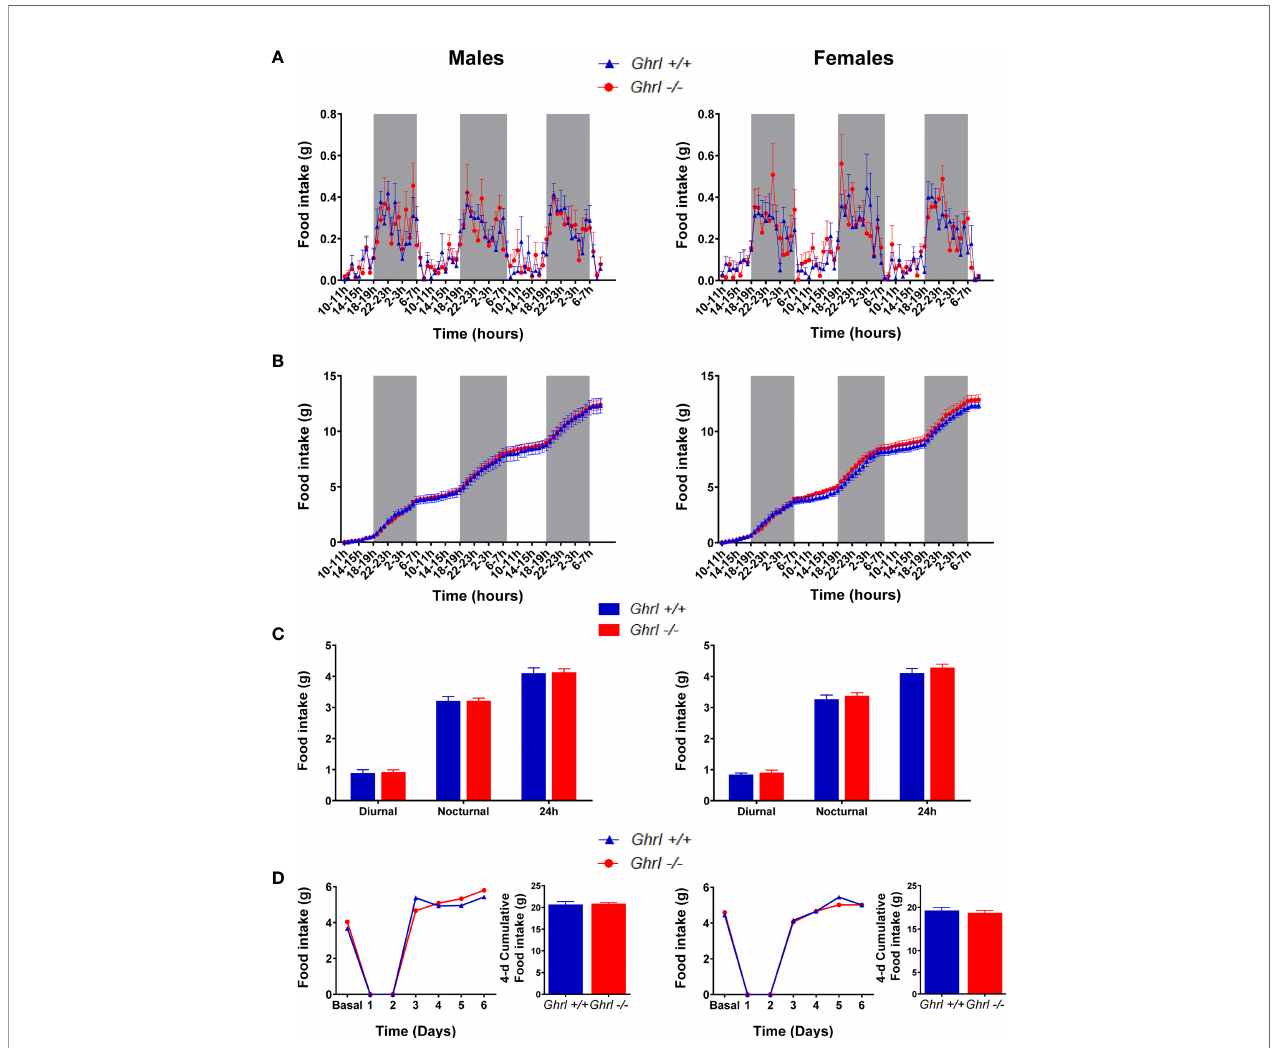
FIGURE 1 | Spontaneous food intake and food intake in a fast-refeeding protocol in male and female Ghrl-/- mice. Feeding parameters in adult male and female Ghrl+/+ and Ghrl-/- mice showing spontaneous food intake (A) and cumulative food intake (B) measured every hour over 3 days as well as diurnal, nocturnal and 24-h food intake averaged over 3 days (C) . Daily food intake and 4-days cumulative food intake during re-feeding (D) in mice fasted for 48-h and then allowed free access to food. Light and dark phases are denoted by white and grey rectangles on the x-axis. Data represent mean ± SEM. Number of mice in panels (A – C) males (n=8 Ghrl+/+ males and 7 Ghrl-/- ), females (n=8 Ghrl+/+ and 8 Ghrl-/- ). Number of mice in panel D: males (n=5 Ghrl+/+ males and 5 Ghrl-/- ), females (n=7 Ghrl+/+ and 6 Ghrl-/-